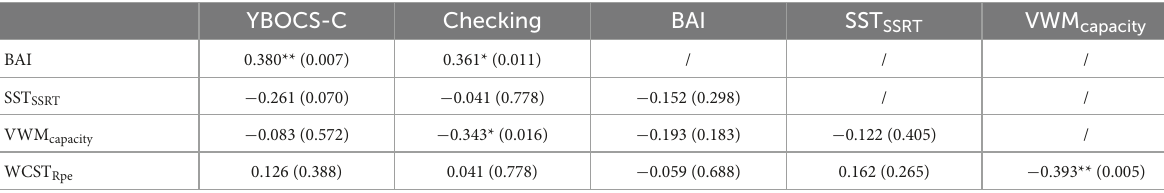
TABLE 3 Correlations between anxiety, executive function indicators, and checking